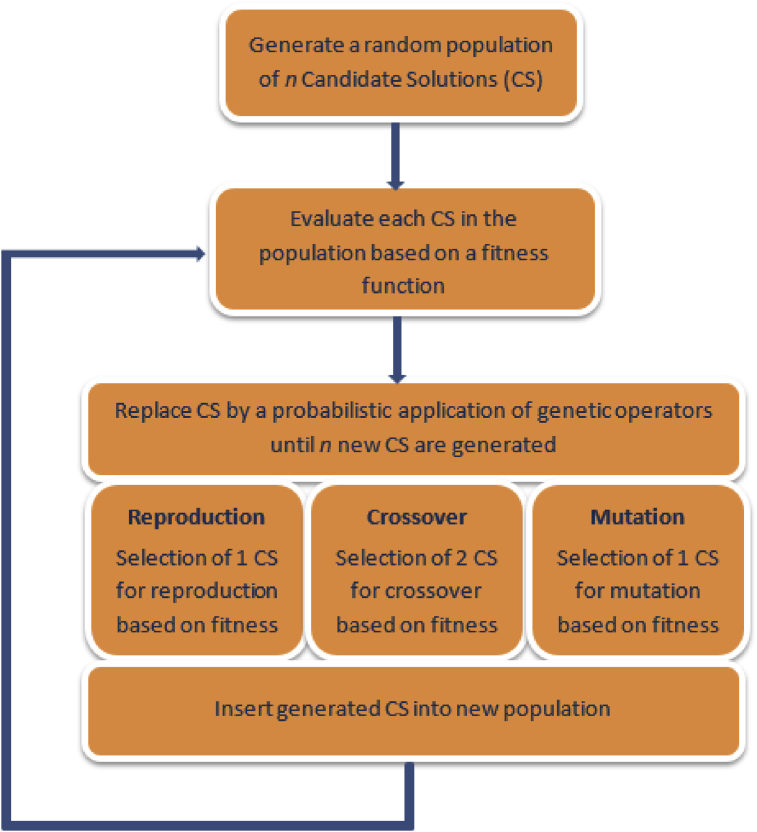
Steps in GP implementation process [Adapted from Sette and Boullart (2001)].